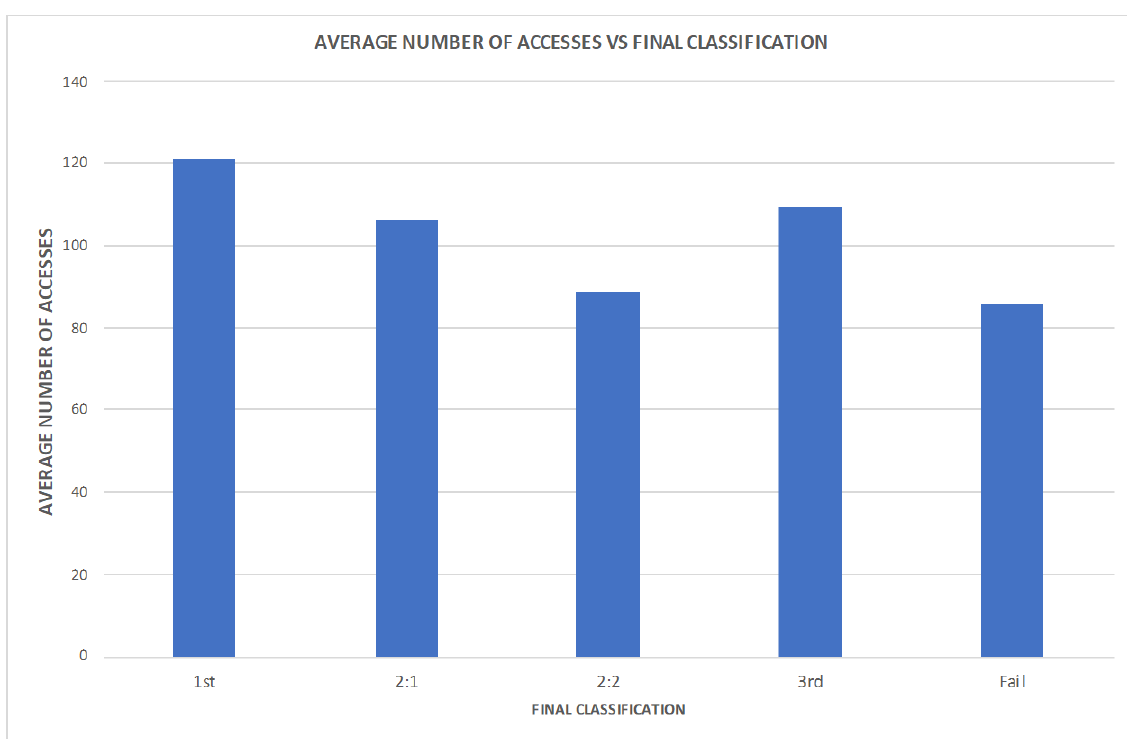
Figur e 5 . Final Classification vs Number of